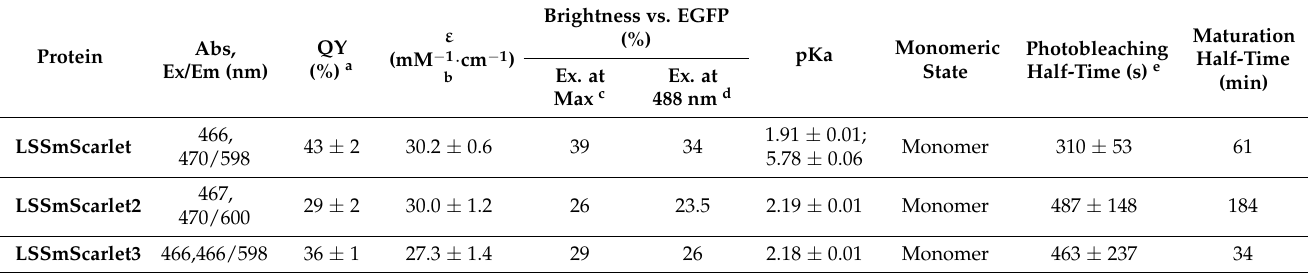
Table 1. In vitro properties of the LSSRFPs. a QY was determined at pH 7.40. LSSmScarlet (QY = 0.43 [9]) was used as the reference standard. b Extinction coefficients were determined by the alkaline denaturation method. c Molecular brightness was calculated as a product of the quantum yield and extinction coefficient at maximal absorption and normalized to the brightness of EGFP, which has an extinction coefficient of 56,000 M − 1 · cm − 1 and quantum yield of 0.6 [1]. d Brightness corrected for the decreased absorption at 488 nm. e Half-time to bleach until 50%. One-photon photobleaching was performed under a metal halide lamp on droplets of protein solution (45 µ M final protein concentration) in oil. The standard deviations are shown.